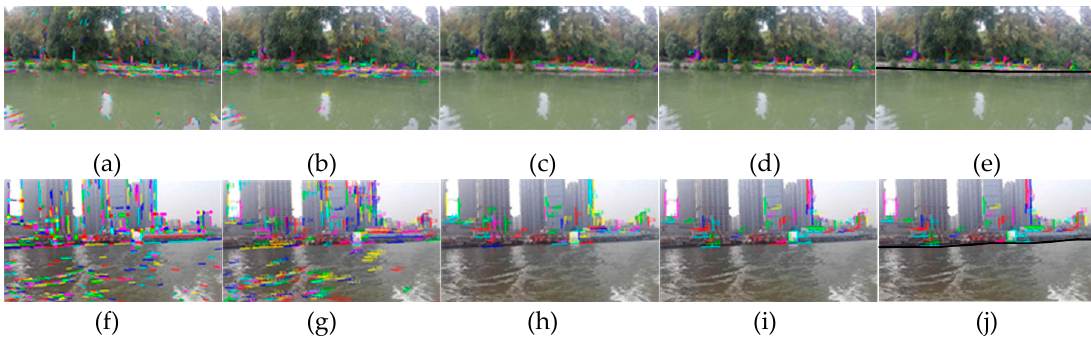
Figure 13. The WSL generation experiments for small scenes: ( a )–( e ) is the experiment I in the East Lake, which is line segment extraction, line segment matching, line segment pool rough selection, line segment pool fine selection and WSL generation. ( f )–( j ) is the experiment II, which is in the Yangtze River.